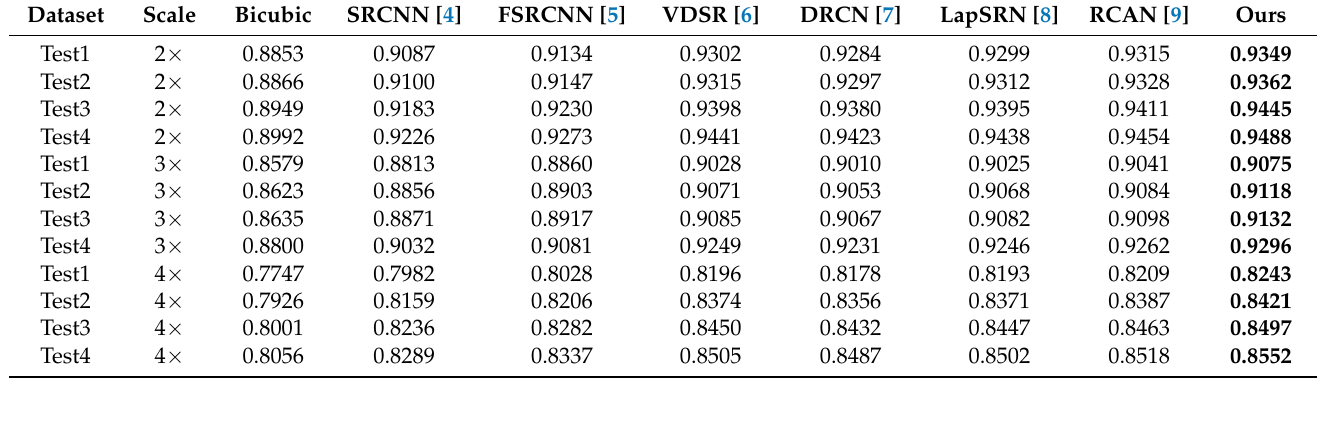
Table 4. Average SSIM for different algorithms at Test1, Test2, Test3 and Test4 datasets.